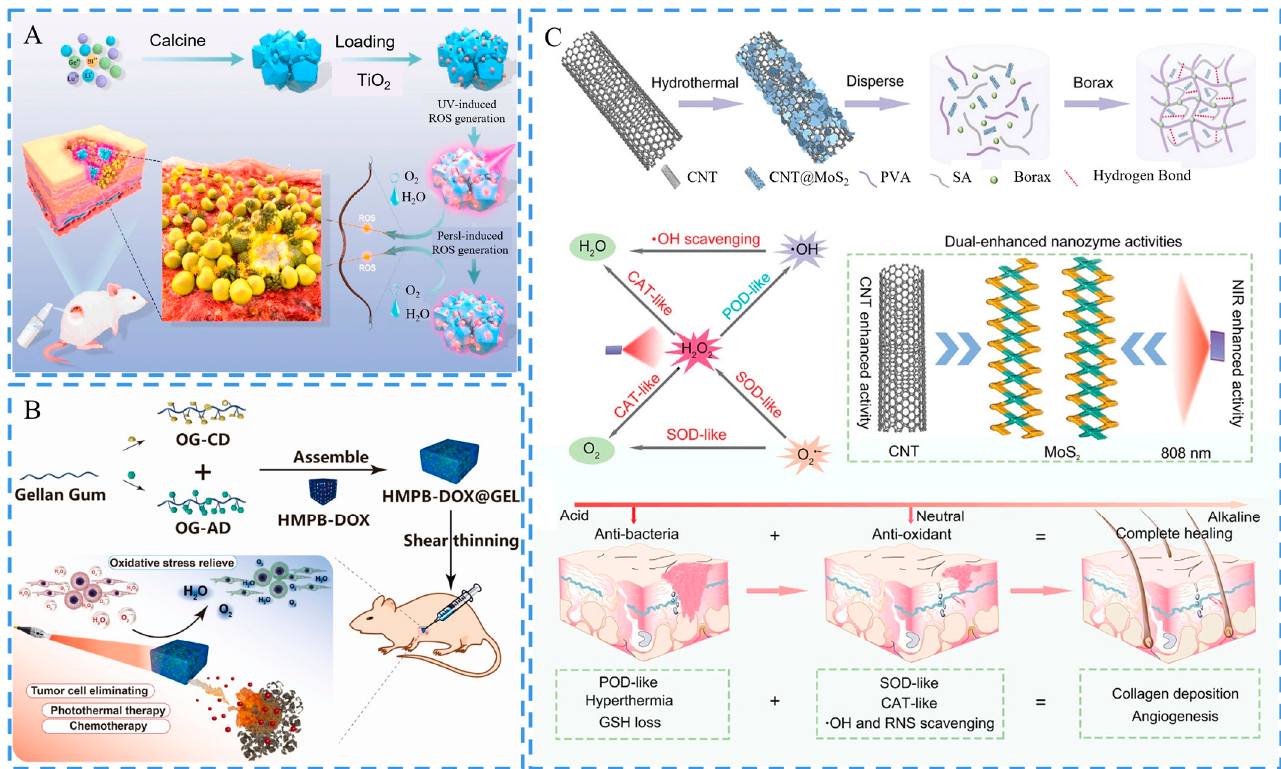
Figure 7. Schematics of the ROS-regulating hydrogels. ( A ) Preparation of the antibacterial photocatalyst LGG/TiO 2 -PF127/PLys/oxidized HA-based hydrogel and its application in infected wound healing. Reproduced with permission [139]. Copyright 2021, Elsevier. ( B ) Schematic of the supramolecular hydrogel containing HMPBs loading doxorubicin (HMPB-DOX@GEL) and its application for tumor postoperative treatment. Adapted with permission [142]. Copyright 2022, Elsevier. ( C ) Schematics of the preparation procedure for the CNT@MoS 2 NSs incorporating PVA/SA hydrogel and the summary of CNT and NIR dual-enhanced triple nanozyme activities. Reproduced with permission [143] . Copyright 2021, Wiley-VCH.